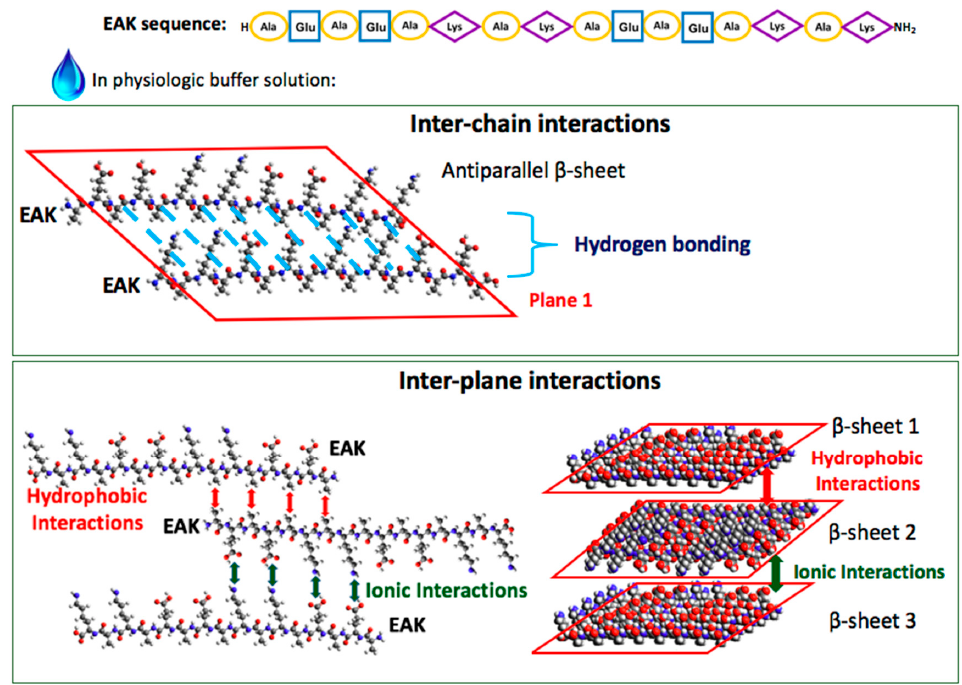
Figure 1. Scheme of peptide self-assembling. The sequence of the self-assembling peptide used in this study (called EAK): hydrophobic amino acids are circled in yellow, hydrophilic amino acids are in blue squares (acid amino acids, negatively charged at neutral pH) or in violet diamonds (basic amino acids, positively charged at neutral pH).